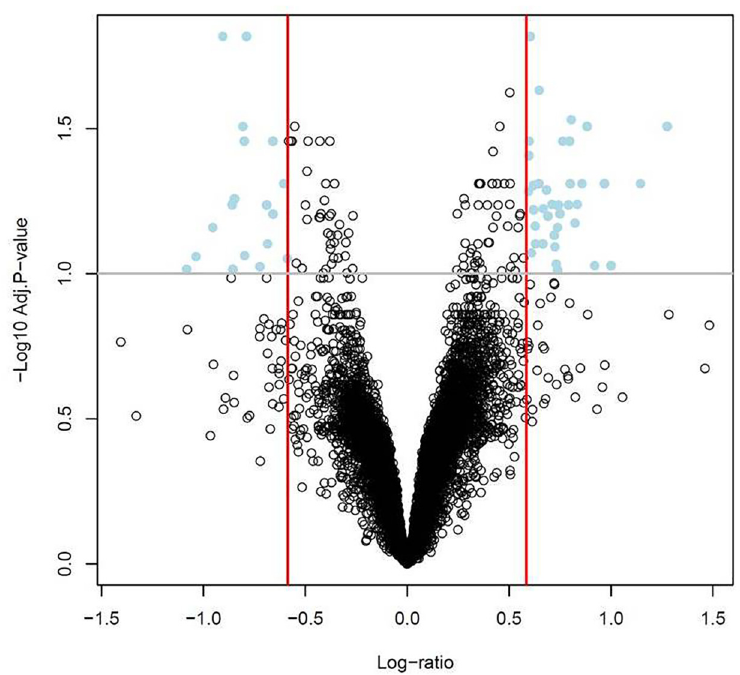
had decreased expression, and 37 genes had increased expression in the subcutaneous adipose tissue of pregnant compared with non-pregnant women. A “ volcano plot ” shows the differential expression of all tested transcripts, with the log (base 10) of the FDR-adjusted probability values (y-axis) plotted against the log (base 2) fold-changes (x-axis) between pregnant and non-preg- nant groups (Fig 3). The heat map in Fig 4 uses a color scale to show the consistency of the expression levels within each group of samples as well as the differences between the groups that led to the positive test results. A list of the top 10 differentially expressed transcripts in the